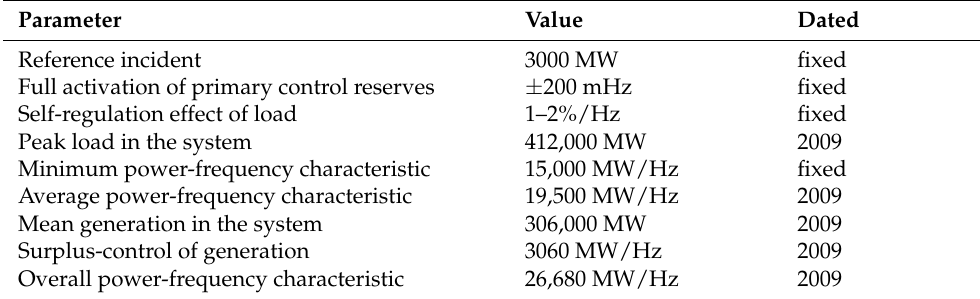
Table 1. Operational data for the calculation of power-frequency characteristics of the Continental Europe synchronous area